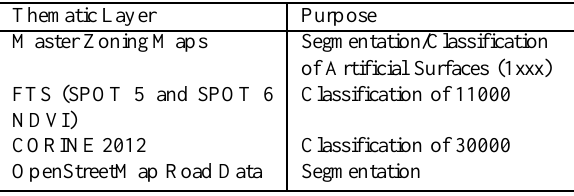
Table 1. Tasks of thematic layers in classification Segmentation parameters show variability in image segmentation process related to spatial resolution of image and minimum mapping unit. Appropriate segment size of objects was utilized to identify objects according to Urban Atlas project standards. Scale, shape and compactness parameters applied to SPOT 5 and